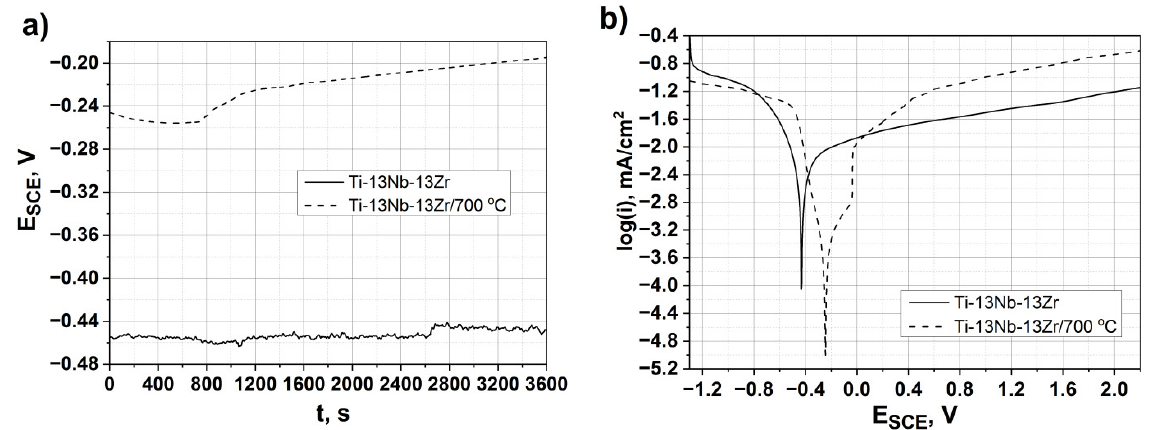
Figure 8. Electrochemical measurements of as-received and oxygen hardened alloy (Ti–13Nb–13Zr/700 °C) in Ringer’s solution at 37 °C, ( a ) evolution of the corrosion potential vs. time and ( b ) polarization curves at 1 mV/s.